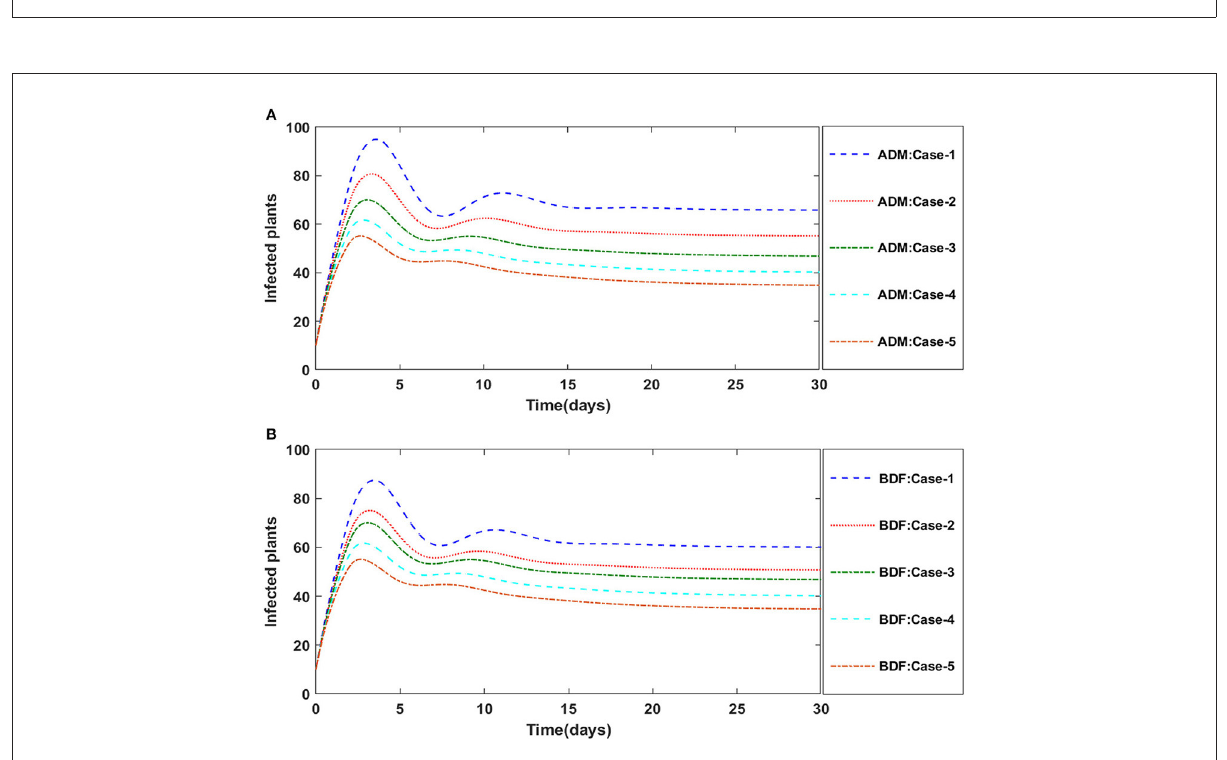
FIGURE7 (A) Dynamics of infected plants for the varition in υ using ADM for model A1. (B) Dynamics of infected plants for the varition in υ using BDF for model